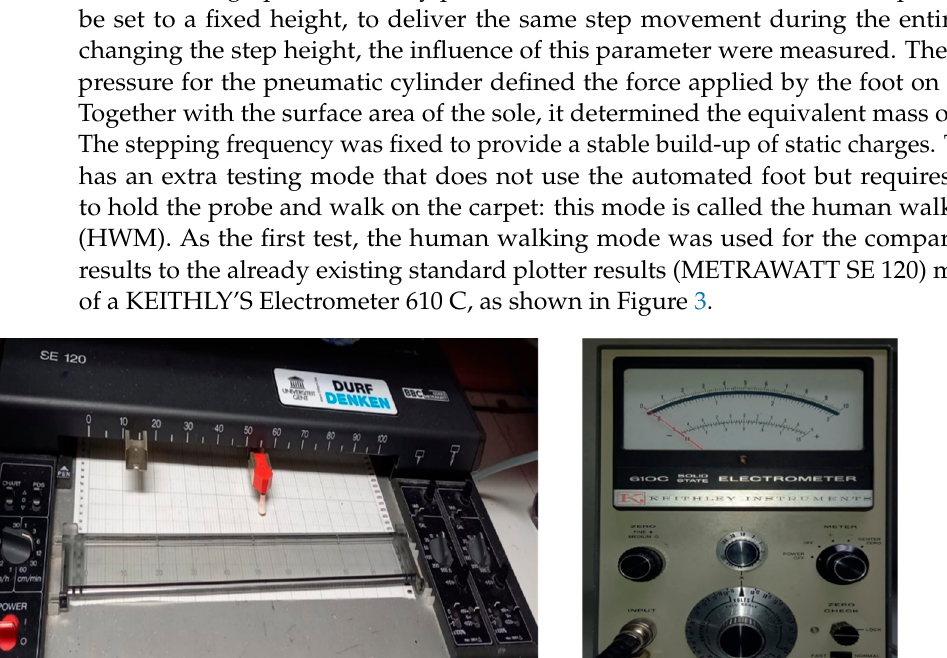
Figure 4. Schematic diagram of the new electrostatic characterization set up. The data read by the ADC were transmitted to a graphical user interface (GUI) on the PC and displayed on a real time chart. It offered direct feedback to the user for opti- mized control. The user interface also controlled all parts of the mechanical system offer- ing a fully automated test procedure. The GUI thus provided central control over the sys- tem, including set-up and calibration of the system. An extra screen was added to provide easy reviewing of the previously recorded data. The goal of the walking test was to deter- mine the maximum accumulated charge over the person or its equivalent. This was done by averaging both the five highest valleys and the five highest peaks of the measured voltage. Once all the data was acquired, an algorithm automatically detected these valleys and peaks. The output was projected on the chart to provide immediate feedback for the user. All results were also saved in a folder of preference, making fast data collection pos- sible. For the new device, the data was read by a National Instrument DAQ and recorded through a graphical user interface (GUI) on the PC, and displayed on a real-time chart. It offered direct feedback to the user for optimized control. The user interface also controlled all parts of the mechanical system offering a fully automated test procedure. The GUI thus